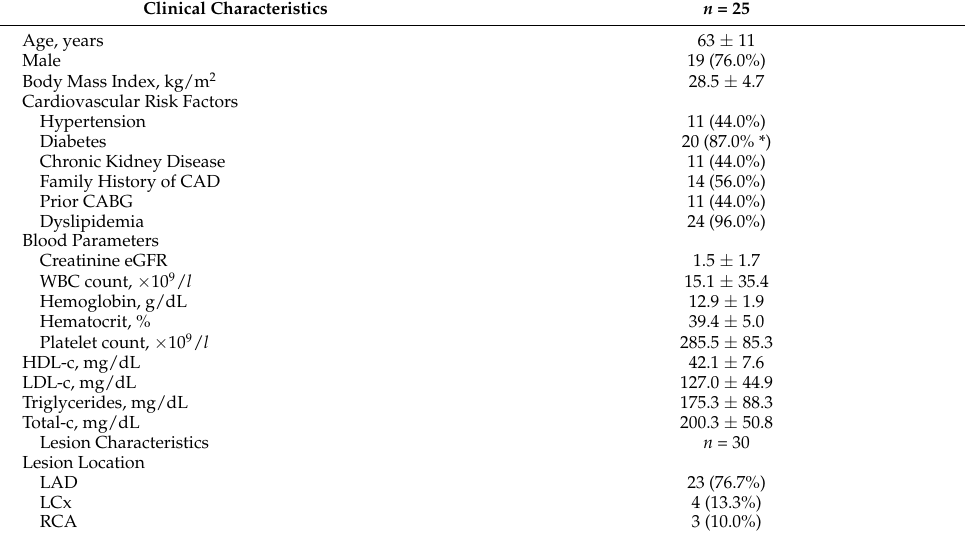
Table 1. Clinical variables of the study population. Values are mean ± standard deviation (SD) for continuous variables, and n (%) for categorical variables. The FHx of CAD, family history of coronary artery disease; CABG, coronary-artery-bypass graft; eGFR, estimated glomerular filtration rate; WBC, white blood cell; LAD, left anterior descending artery; LCx, left circumflex artery, RCA, right coronary artery. * Two missing